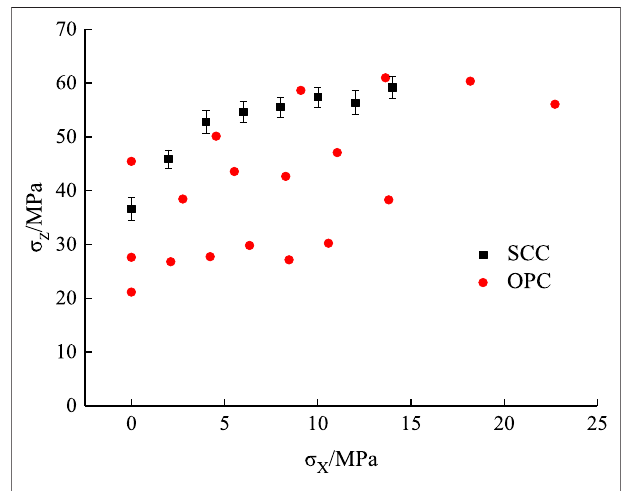
FIGURE 10 | The principal compressive stress and lateral compressive stress of SCC.